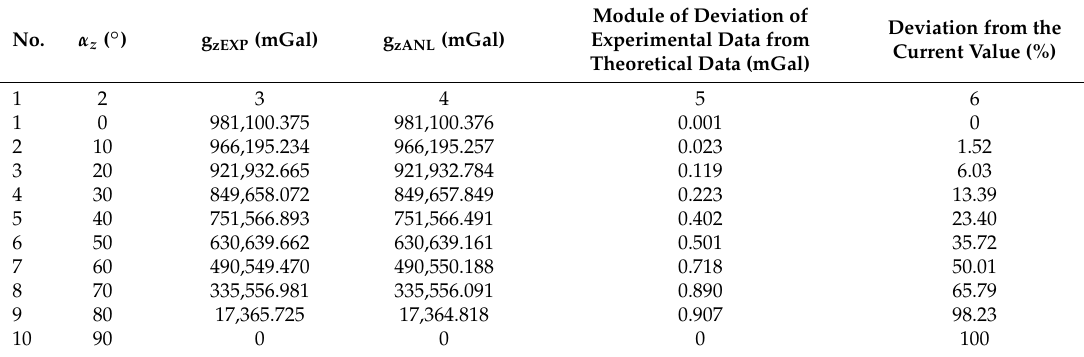
Table 3. Calibration table of the SE